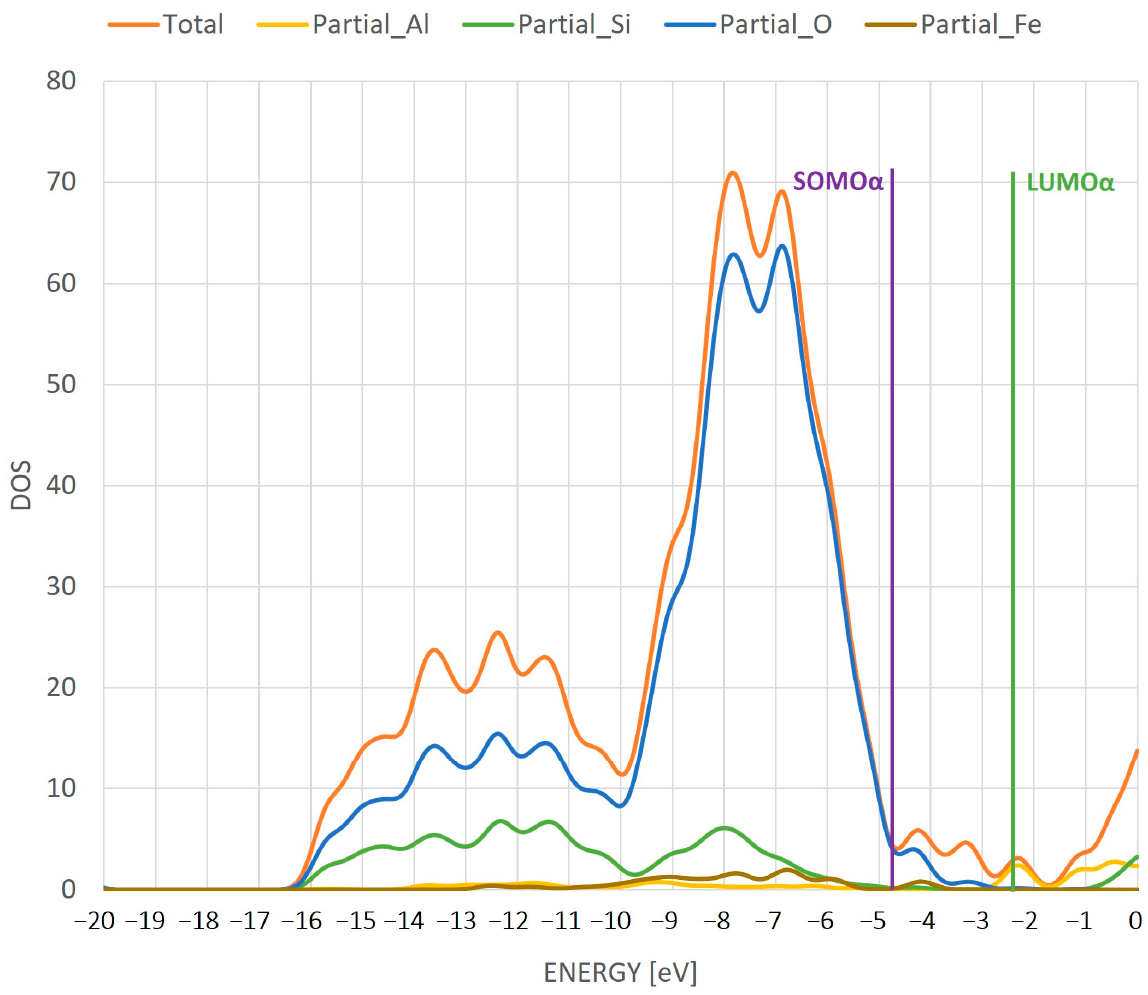
Figure 8. DOS diagram for individual atoms in the ZSM-5 structure with FeOH adsorbed on the active site. The line in the diagram shows the position of SOMO and LUMO orbitals.